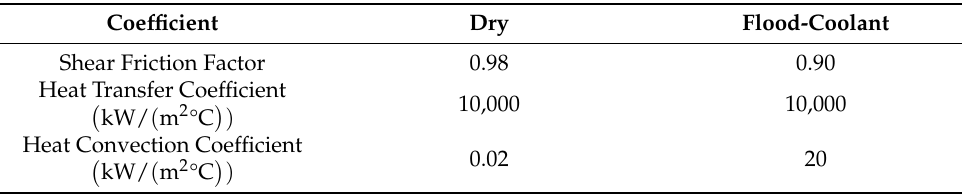
Table 4. The calibrated frictional and thermal coefficients in the FE models.